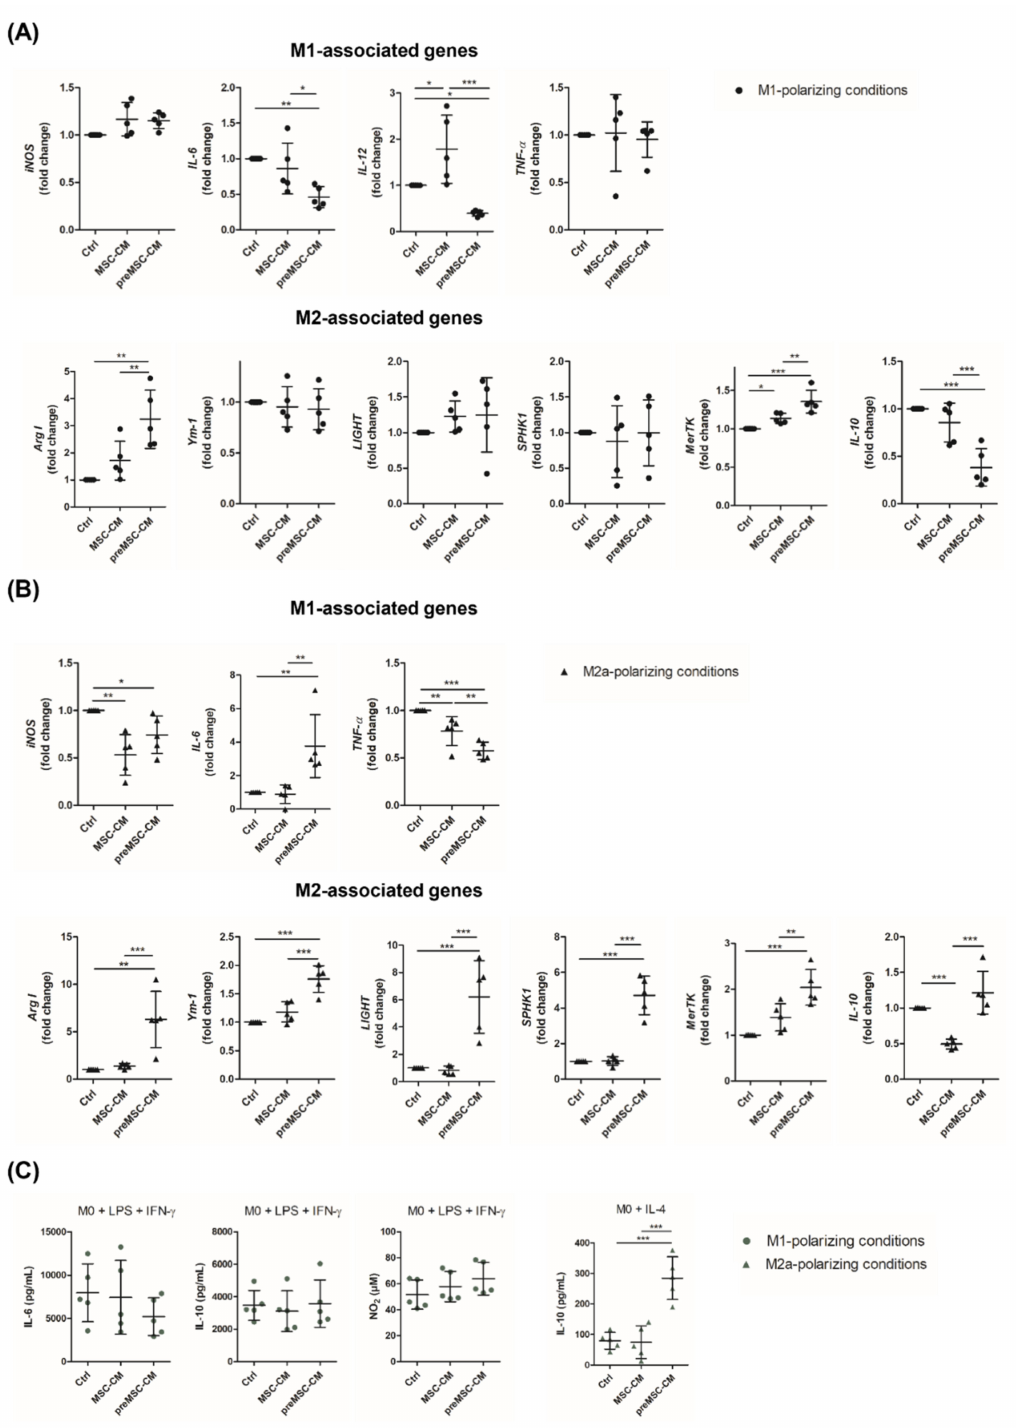
Figure 1. Effect of MSC-CM and preMSC-CM on macrophage polarization. Bone marrow-derived macrophages were cultured under M1-polarizing or M2a-polarizing culture conditions in